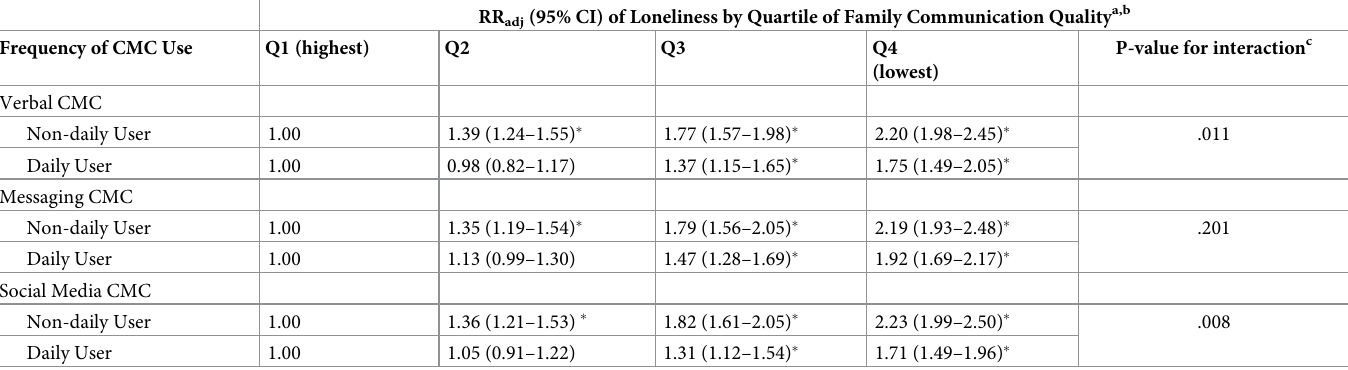
Table 3. The association between family communication quality and loneliness by non-daily and daily CMC use as reported by Canadian adolescents (n = 23,218). RR adj (95% CI) of Loneliness by Quartile of Family Communication Quality a,b